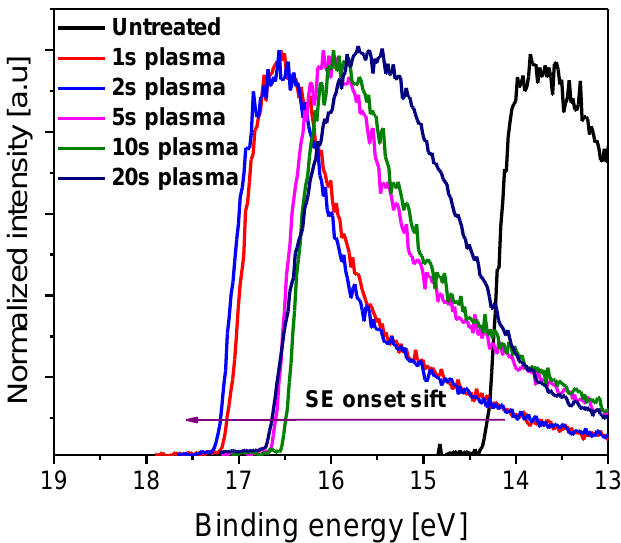
Figure 3. Secondary electron (SE) onset of the mixed-halide perovskite film obtained by UPS before and after plasma treatment.